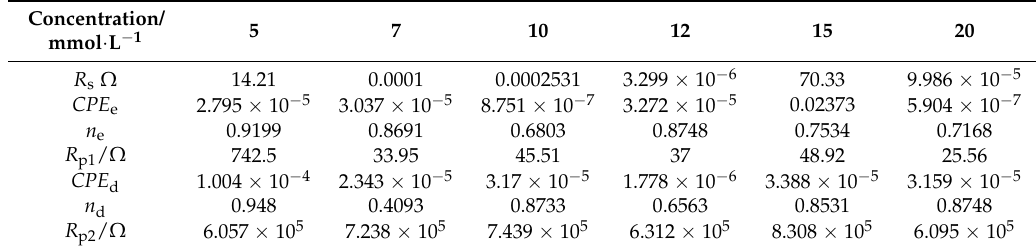
Table 4. Dependence of electrochemical corrosion properties of TA2 electrode on glucose concentration. Concentration/